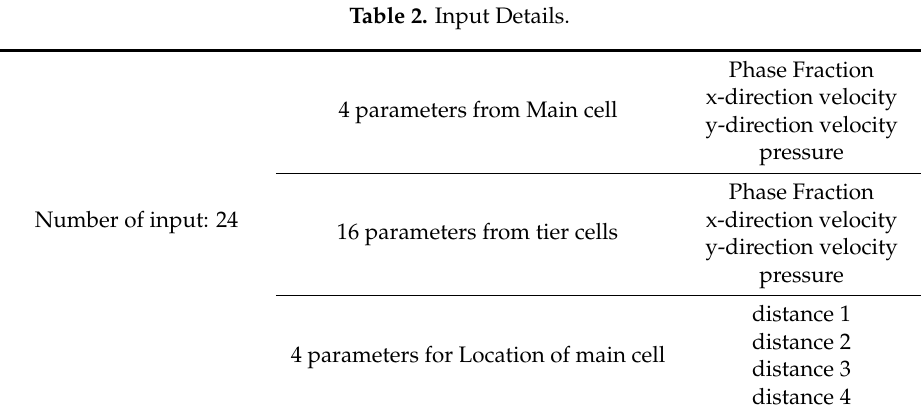
Figure 3. Artificial neural network (ANN) model preparation workflow.